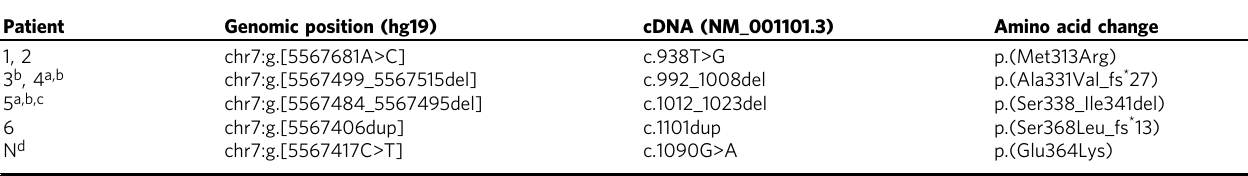
Table 1 Summary of ACTB -AST